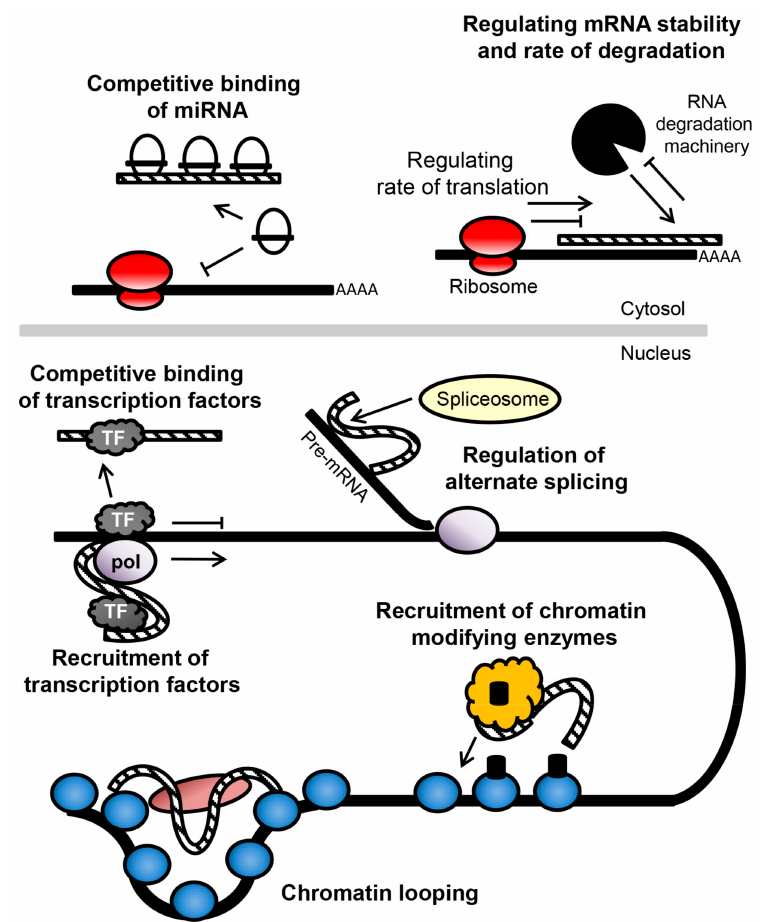
Figure 2. A summary of the mechanisms of action of long non-coding RNA (lncRNA). Long non-coding RNA (dashed line) can act to regulate translation of mRNA by (i) controlling miRNA availability by competing with miRNA target sites on the mRNA or (ii) binding to the mRNA to control the rate of translation or RNA degradation. Within the nucleus, lncRNA can affect transcription by (iii) acting as decoy to inhibit transcription factor availability or (iv) recruiting the transcription factors to the promoter site, or by (v) regulating alternative splicing of the transcript. lncRNA can also affect epigenetic state and chromosome structure by (vi) recruiting chromatin modifying enzymes to the DNA and (vii) controlling chromatin looping. Abbreviations: TF, transcription factor; pol, RNA